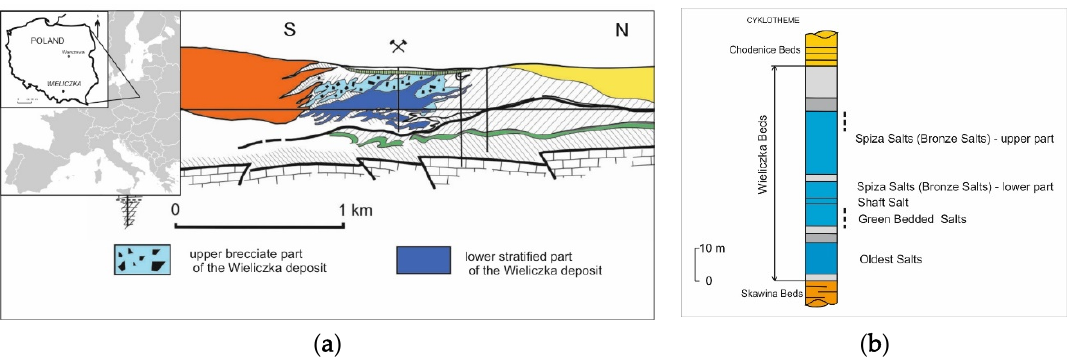
Figure 6. (a) Cross-section of the Wieliczka salt deposit, Central Poland (after Poborski 1977, [29], simplified by the authors); (b) stratigraphic profile of the Miocene (Badenian) salt deposit in Wieliczka mine, with matched Spiza Salt and Green Bedded Salts stratigraphic levels (after Garlicki 1979, [30], simplified and modified by the authors).